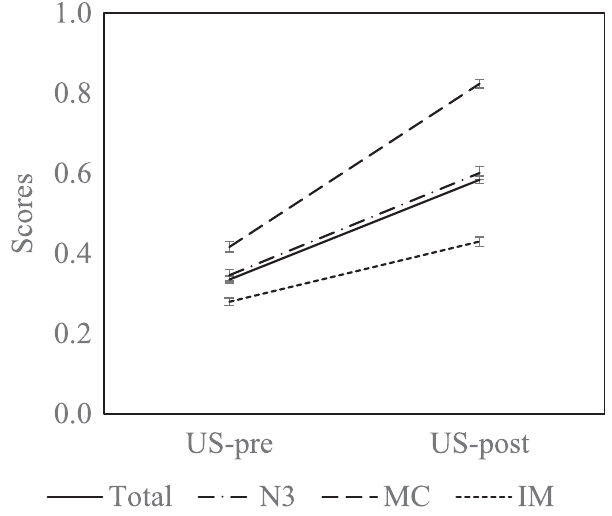
FIG. 4. Pretesting and post-testing performance of students for different concepts including momentum conservation, impulse- momentum theorem, and Newton ’ s third law, as well as the total score. The error bars represent the standard error of the